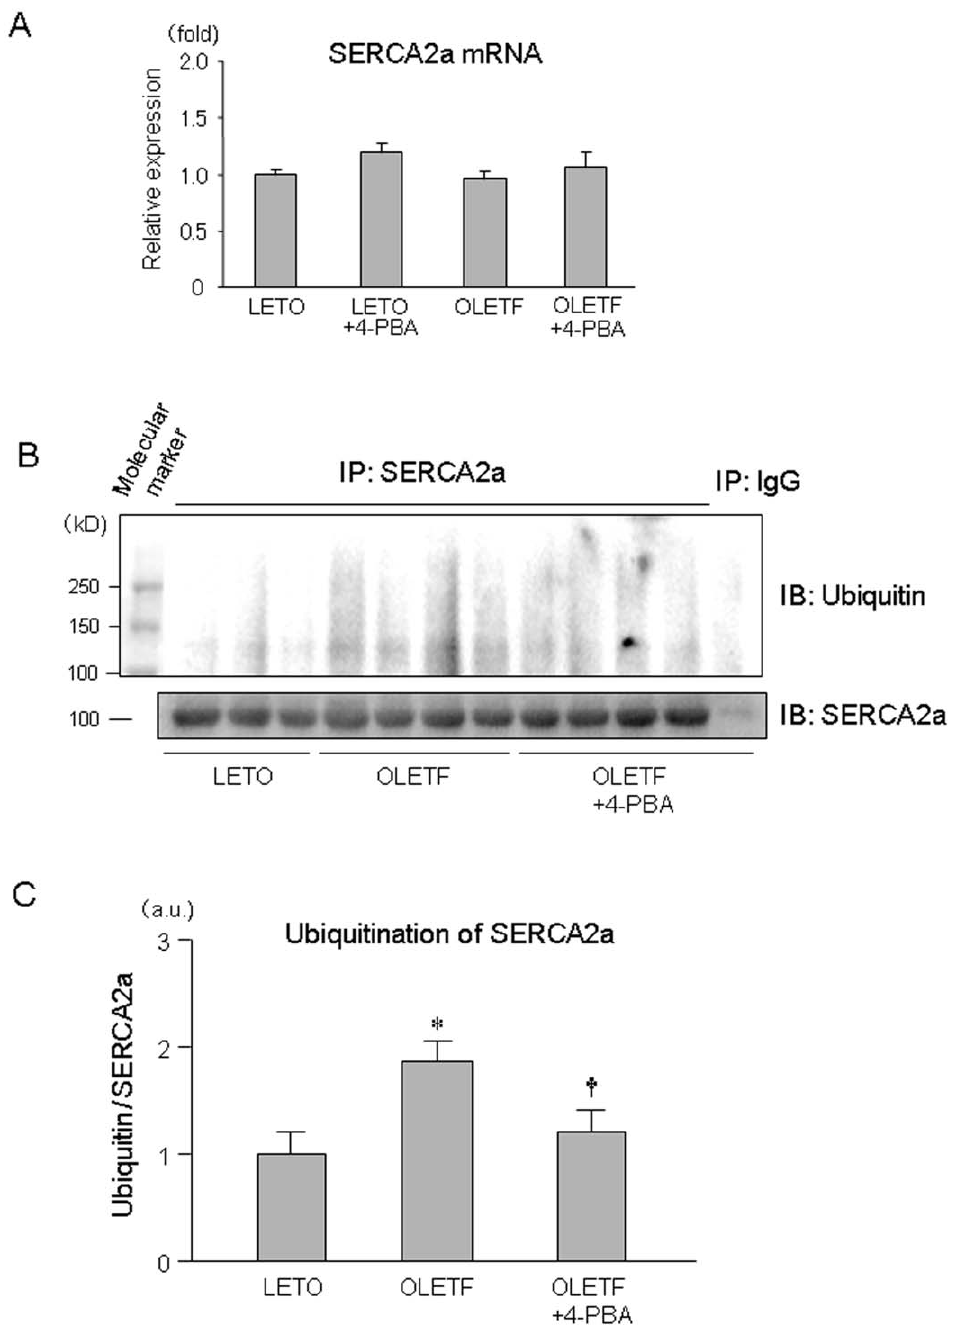
Figure 5. Alterations in mRNA expression and ubiquitination of SERCA2a in OLETF. Summary data of SERCA2a mRNA (A), representative blot (B) and summary data (C) of ubiquitination of SERCA2a protein are shown. *p , 0.05 vs. LETO, { p , 0.05 vs. OLETF. n=5. SERCA2a=